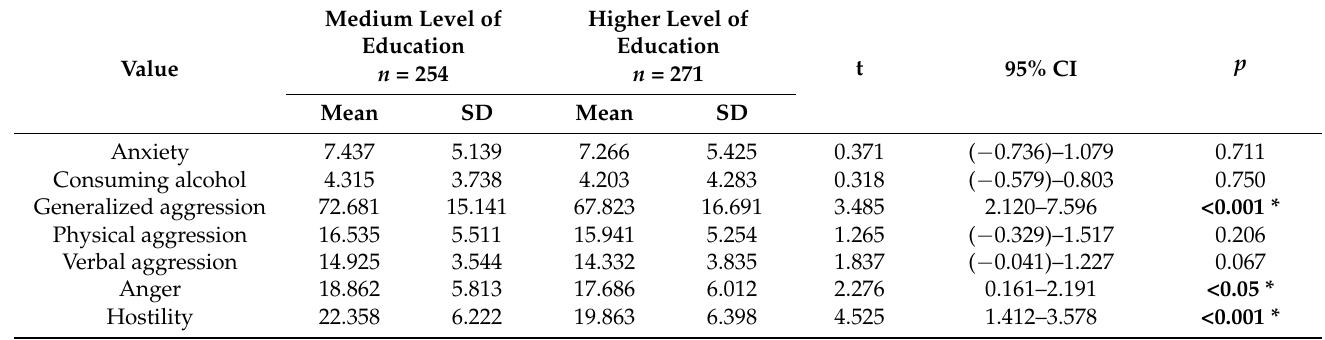
Table 6. Differences between educational groups concerning the parameters tested.